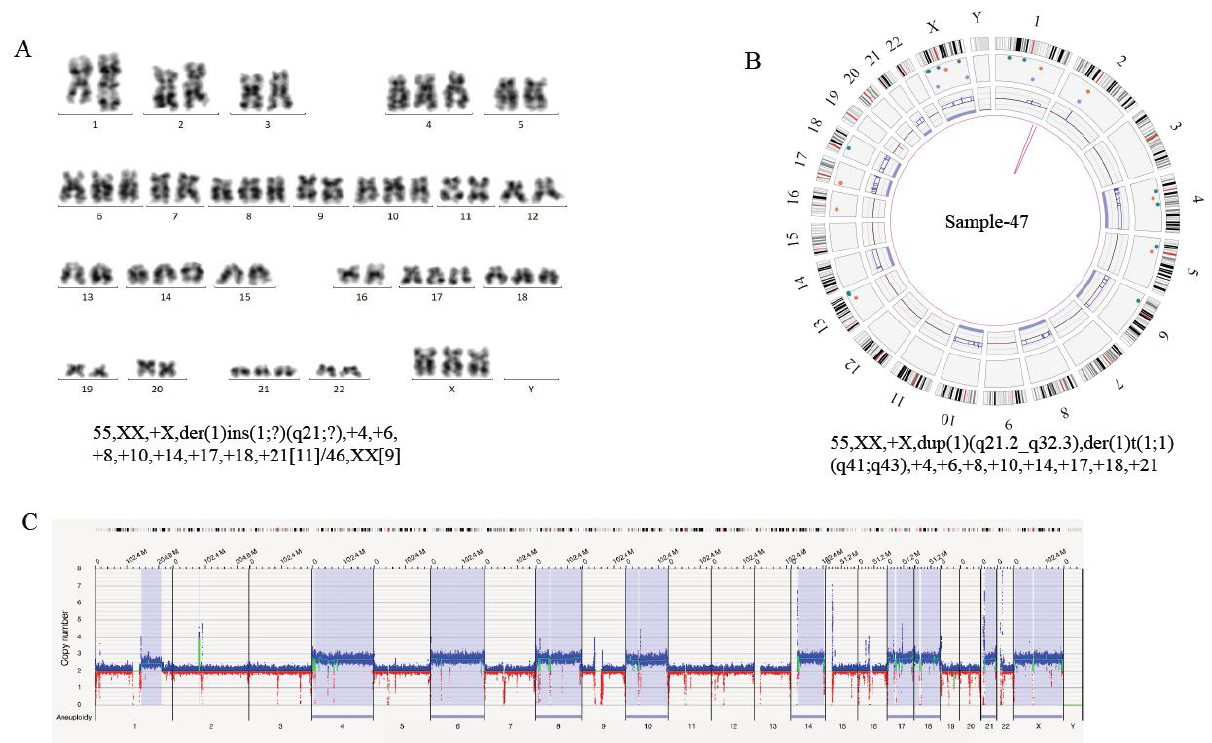
Figure 3. Production of an Accurate Cytogenomic Karyotype by Refining Cytogenetic Breakpoints and Resolving Unknown Cytogenetic Elements by OGM. ( A ) Standard G-banded karyotyping in sample 47 show the karyotype as 55, XX, +X, der(1)ins(1;?)(q21;?),+4,+6,+8,+10,+14,+17,+18,+21[11]/46,XX[9]. ( B ) Circus plot, showing a whole-genome view of a derivative chromosome 1 (pink lines) and copy number profiles (inner circle blue boxes indicate gains and red boxes indicate deletions). Thus, OGM identified additional intra-chromosomal translocation in chromosome 1 and refined the karyotype as 55, XX, +X, dup(1)(q21.2q24.3-q24.3q32.3), der(1) t(1;1)(q41;q43), +4,+6,+8,+10,+14,+17,+18,+21. ( C ) Whole-genome CNV profiles, generated with Bionano Access, indicates gains of chromosome 4, 6, 8, 10, 14, 17, 18, 21, 23. Some regions of chromosome 1 were amplified, and the y axis shows copy numbers ranging from 0 – 8 for each chromosome. The x axis shows increased copy numbers in blue and decreased copy numbers in red. The light blue region, highlighted for the above chromosomes, indicates a significant difference from the baseline, thus flagging a gain in those chromosomes. All chromosomes, except the sex chromosomes (Y)×0 and chromosomes (4, 6, 8, 10, 14, 17, 18, 21, 23) ×3, are present in 2 copies.